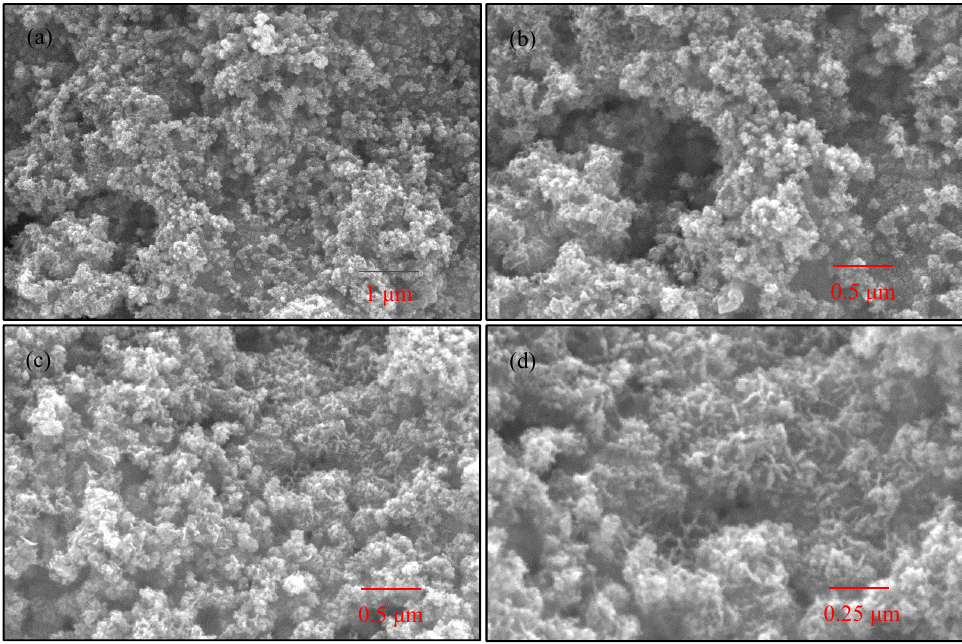
Figure 7. SEM images of copper sulfide slag: ( a ) 50,000 × ; ( b ) 100,000 × ; ( c ) 100,000 × ; ( d ) 200,000 ×